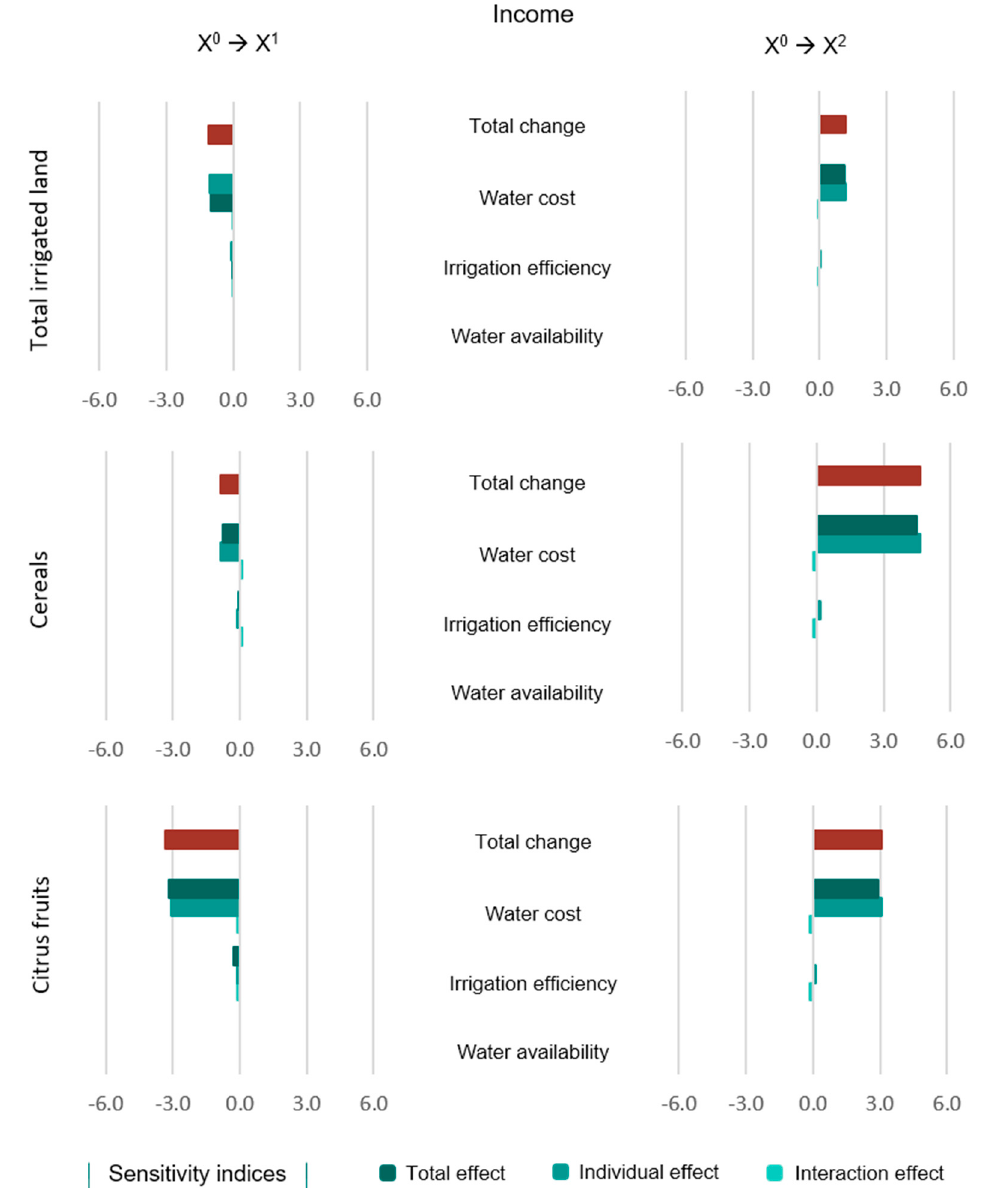
Figure 4. Sensitivity of income (total, cereals and citrus fruits) to scenario drivers when shifting from the reference to the worst-case scenario ( left ) and to the best-case scenario ( right ). The total change in income is decomposed into changes due to total, individual and interaction effects of each driver. The results are presented as % change from reference scenario.